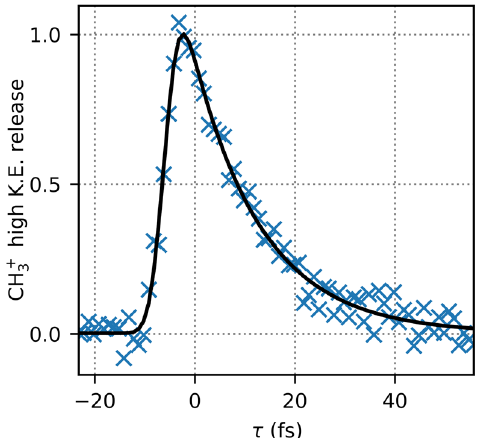
6. Transient high kinetic energy CH þ 3 ion yield, attributed to the decay of the intermediate cationic channel in isopropanol using an XUV pump at 20 eV and 650 as duration and a 4 fs IR probe to induce transitions to the second ionization